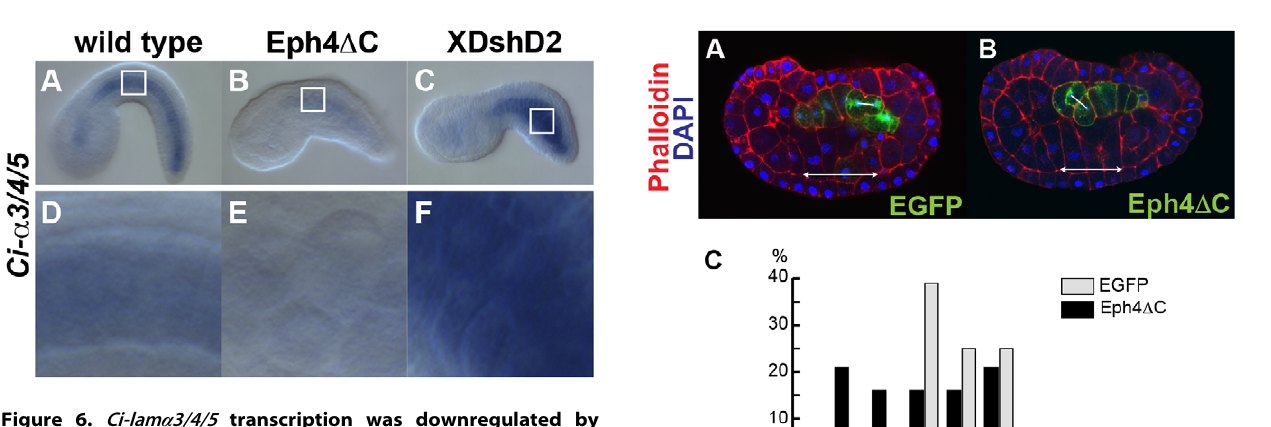
Figure 6. Ci-lam a 3/4/5 transcription was downregulated by misexpression of Eph4 D C but not by that of XDshD2. Ci-lam a 3/ 4/5 transcripts detected by in situ hybridizaion in a wild type (A), transfected with Eph4 D C (B), and transfected with XDshD2 (C) embryos. D, E and F are higher magnification the boxed area in A, B and C, respectively.